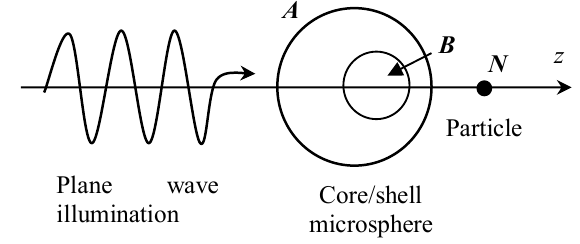
Figure 1: Core ( B ) / shell ( A ) microshere and nanoparticle ( N ) illuminated by plane